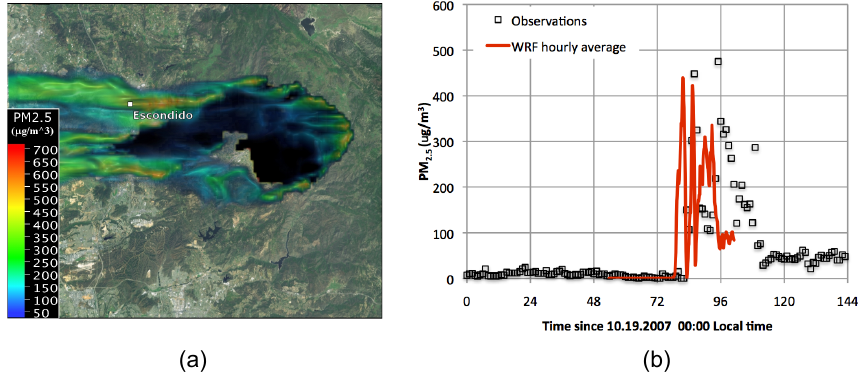
Figure 11. An example of the PM 2 . 5 concentration field in µgm 3 , simulated for the Witch and Guejito fires in California using WRF– SFIRE–Chem. (a) Simulated PM 2 . 5 on 22 October 2007, 13:00LT (hour 85 since 19 October 2007, 00:00LT) with the location of the Escondido air-quality station. Only concentrations above 50 µg / m 3 are shown, and the black fill in the background represents the burnt area, (b) Simulated hourly averaged PM 2 . 5 (red line) and observations (black points) from Escondido air-quality station, marked as the white squares on (a) .